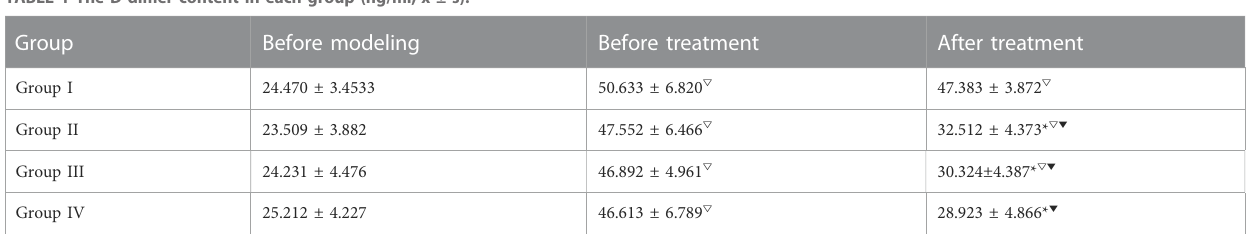
TABLE 1 The D-dimer content in each group (ng/ml, ‾ x ± s). Group Before modeling Before treatment After